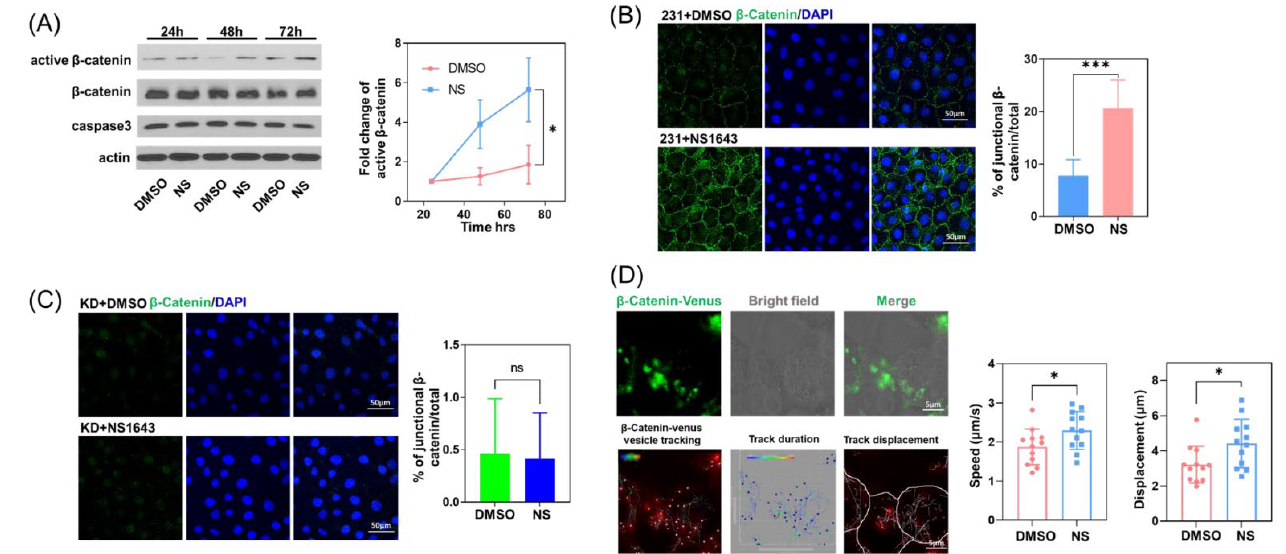
Figure 4. β -catenin at cell junctions increased in the presence of Kv11.1 activator. ( A ) MDA-MB-231 cells treated with DMSO or 50 μM NS1643 for 24, 48, or 72 h were lysed and subjected to Western blotting. NS treatment did not change apoptosis marker caspase-3, but increased the level of active β -catenin, n = 3. * p < 0.05 via ANOVA. ( B ) MDA-MB-231 cells treated with DMSO or 50 μM NS1643 for 72 h were fixed and immunostained for β -catenin. Cells were visualized using confocal microscopy. Images were processed using ImageJ. Junctional β -catenin staining increased in NS1643 treated cells, n = 10. ( C ) Cav-1 depleted MDA-MB-231 cells treated with DMSO or 50 μM NS1643 for 72 h were fixed and immunostained for β -catenin. No change in junctional β -catenin staining was detected upon NS1643 treatment in the absence of Cav-1, n = 10. ( D ) MDA-MB-231 cells transfected with β -catenin-Venus were treated with DMSO or 50 μM NS1643 and visualized via confocal microscopy for 30 s. The movement of fluorescent β -catenin vesicles was tracked using Imaris. β -catenin-positive vesicle velocity was increased by NS1643. Total displacement representing the translocation of β -catenin-positive vesicles was also increased by NS1643, n = 10. All data are mean ± SD; ns = not significant * p < 0.05; *** p < 0.001 via t test.